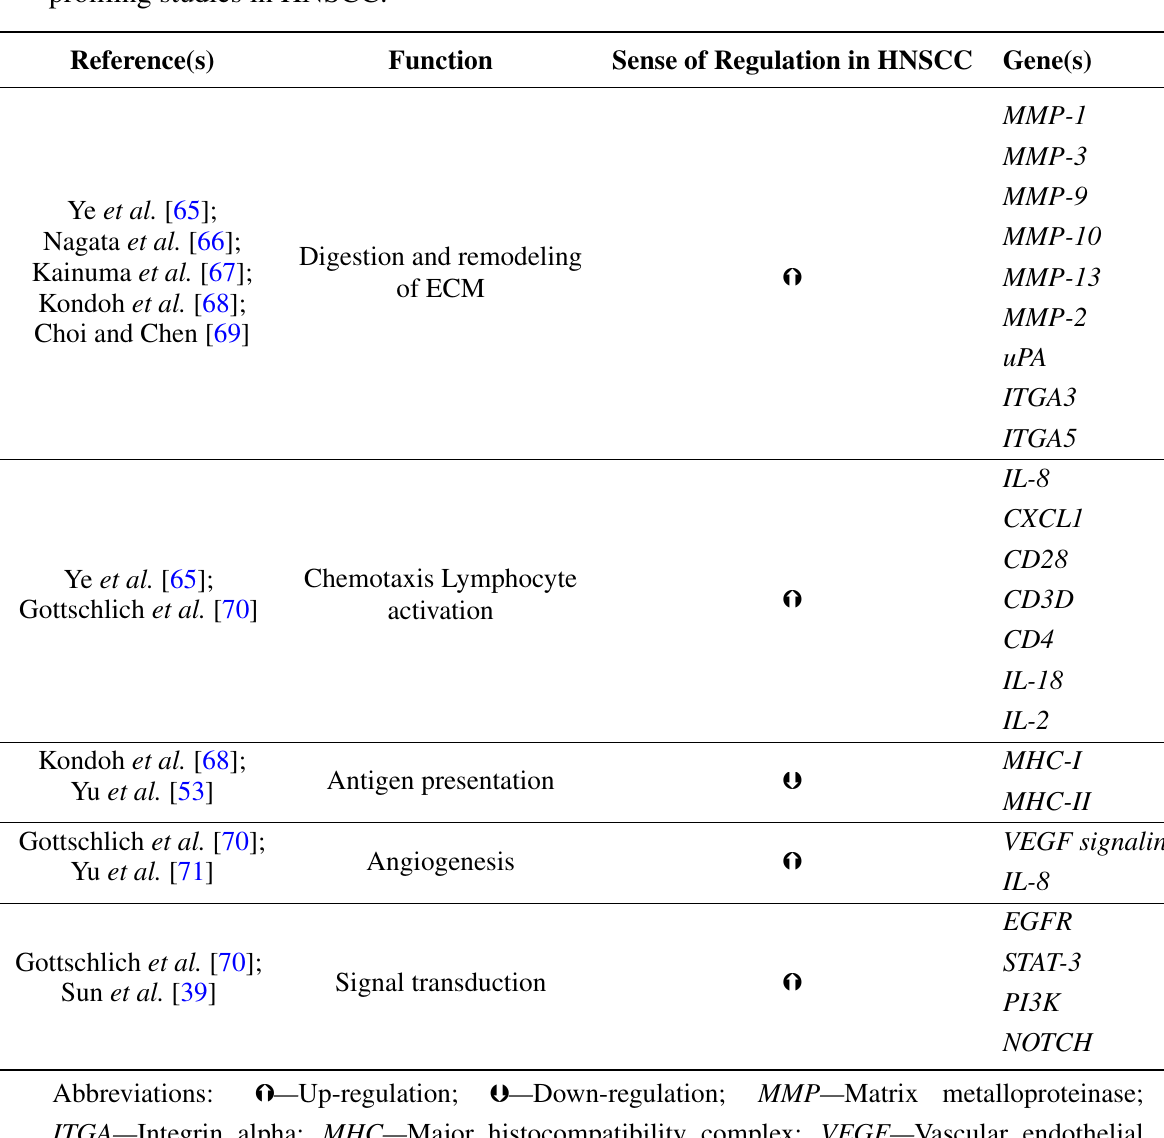
Table 1. Summary of illustrative findings related to invasiveness from gene-expression profiling studies in HNSCC.